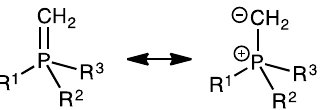
Figure 2. Resonant structures of a phosphonium ylide revealing the electron-richness and the electron-donating character of the carbon end, with propensity to adopt an sp 3 hybridization state in a η 1 -coordination mode toward a transition metal center.